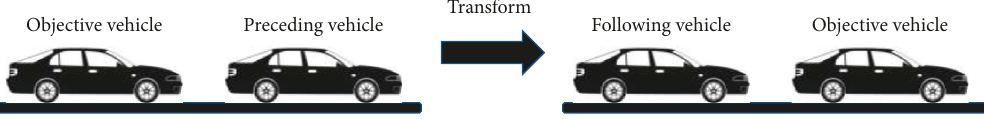
Figure 8: The transformation to fit the model in this passage. Table 5: The ground truth value of each